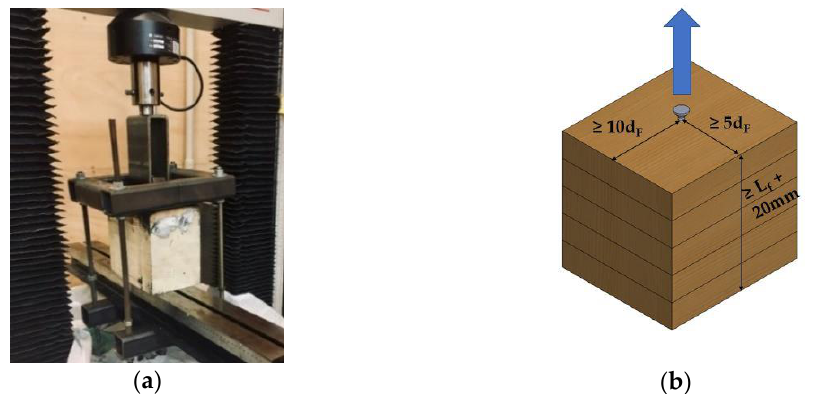
Figure 2. Fire test using conical radiant heater at 50 kW/m 2 : ( a ) Experimental setup with the fas- tener head exposed (side view); ( b ) Experimental setup with the fastener tip exposed (back view).